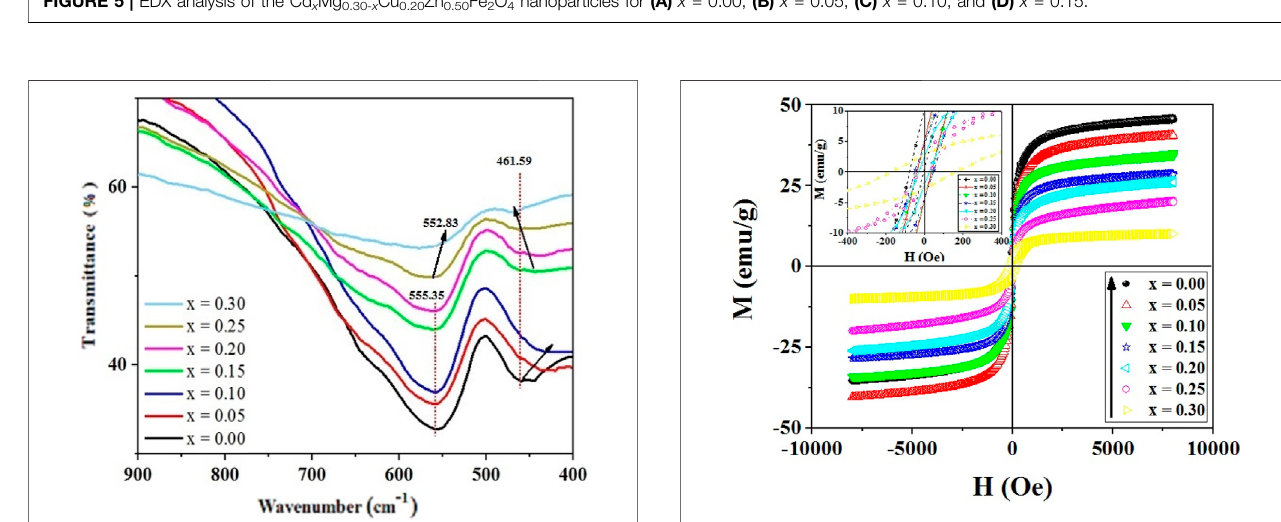
FIGURE 6 | FTIR spectra of Cd x Mg 0.3- x Cu 0.2 Zn 0.5 Fe 2 O 4 ferrites.